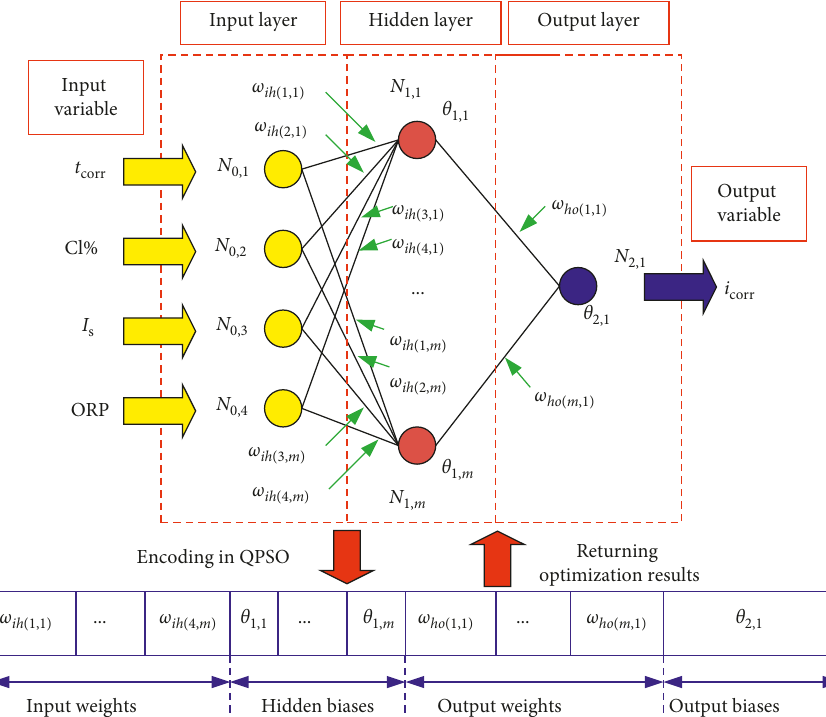
Figure 7: Structure of the ANN and encoding details in